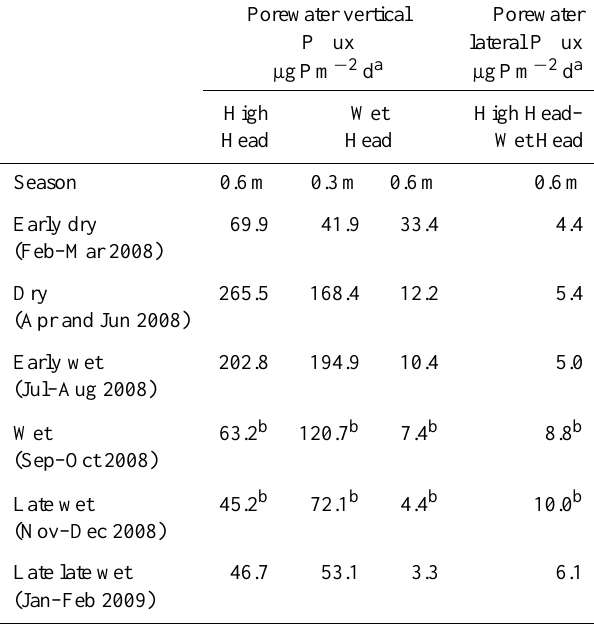
Table 3. Intra-annual variability in vertical (recharge) and lateral porewater total dissolved phosphorus (TDP) fluxes. See text for de- tails of calculations. Porewater vertical